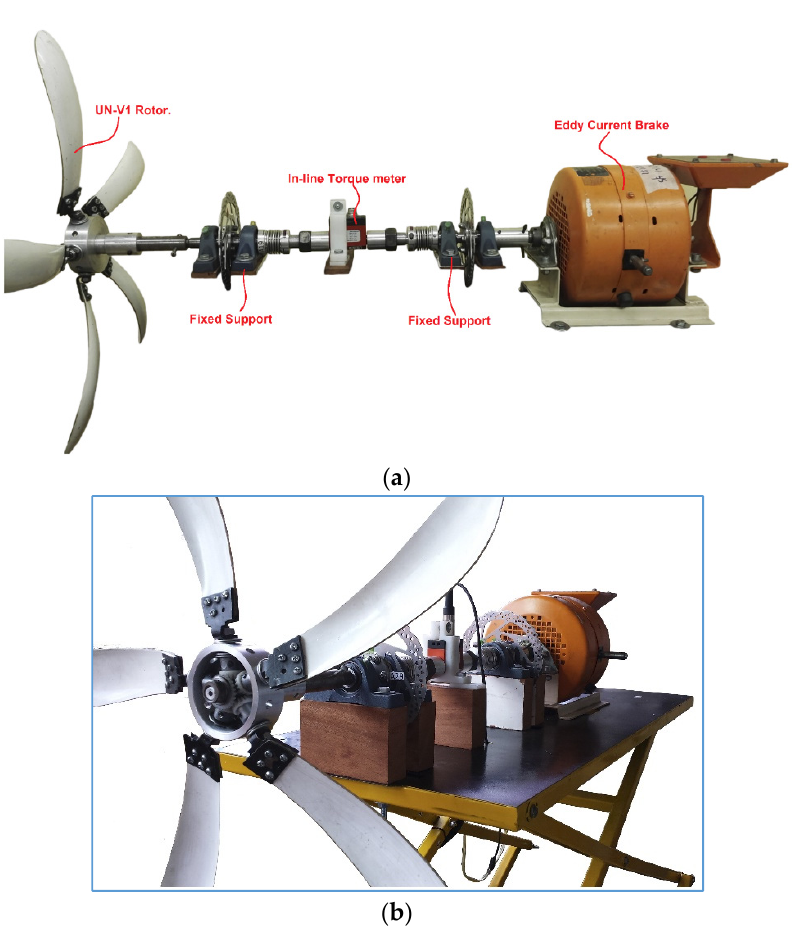
Figure 4. Wind rotor Test bench. ( a ): Main parts. ( b ): Isometric view.